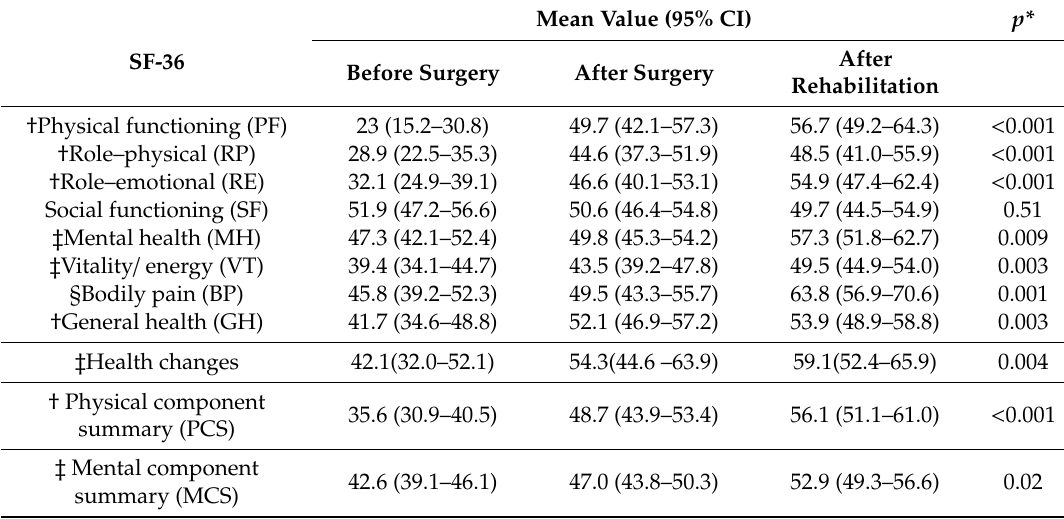
Table 2. Self-assessment of the SF-36 quality of life domain and components before and after surgery and after